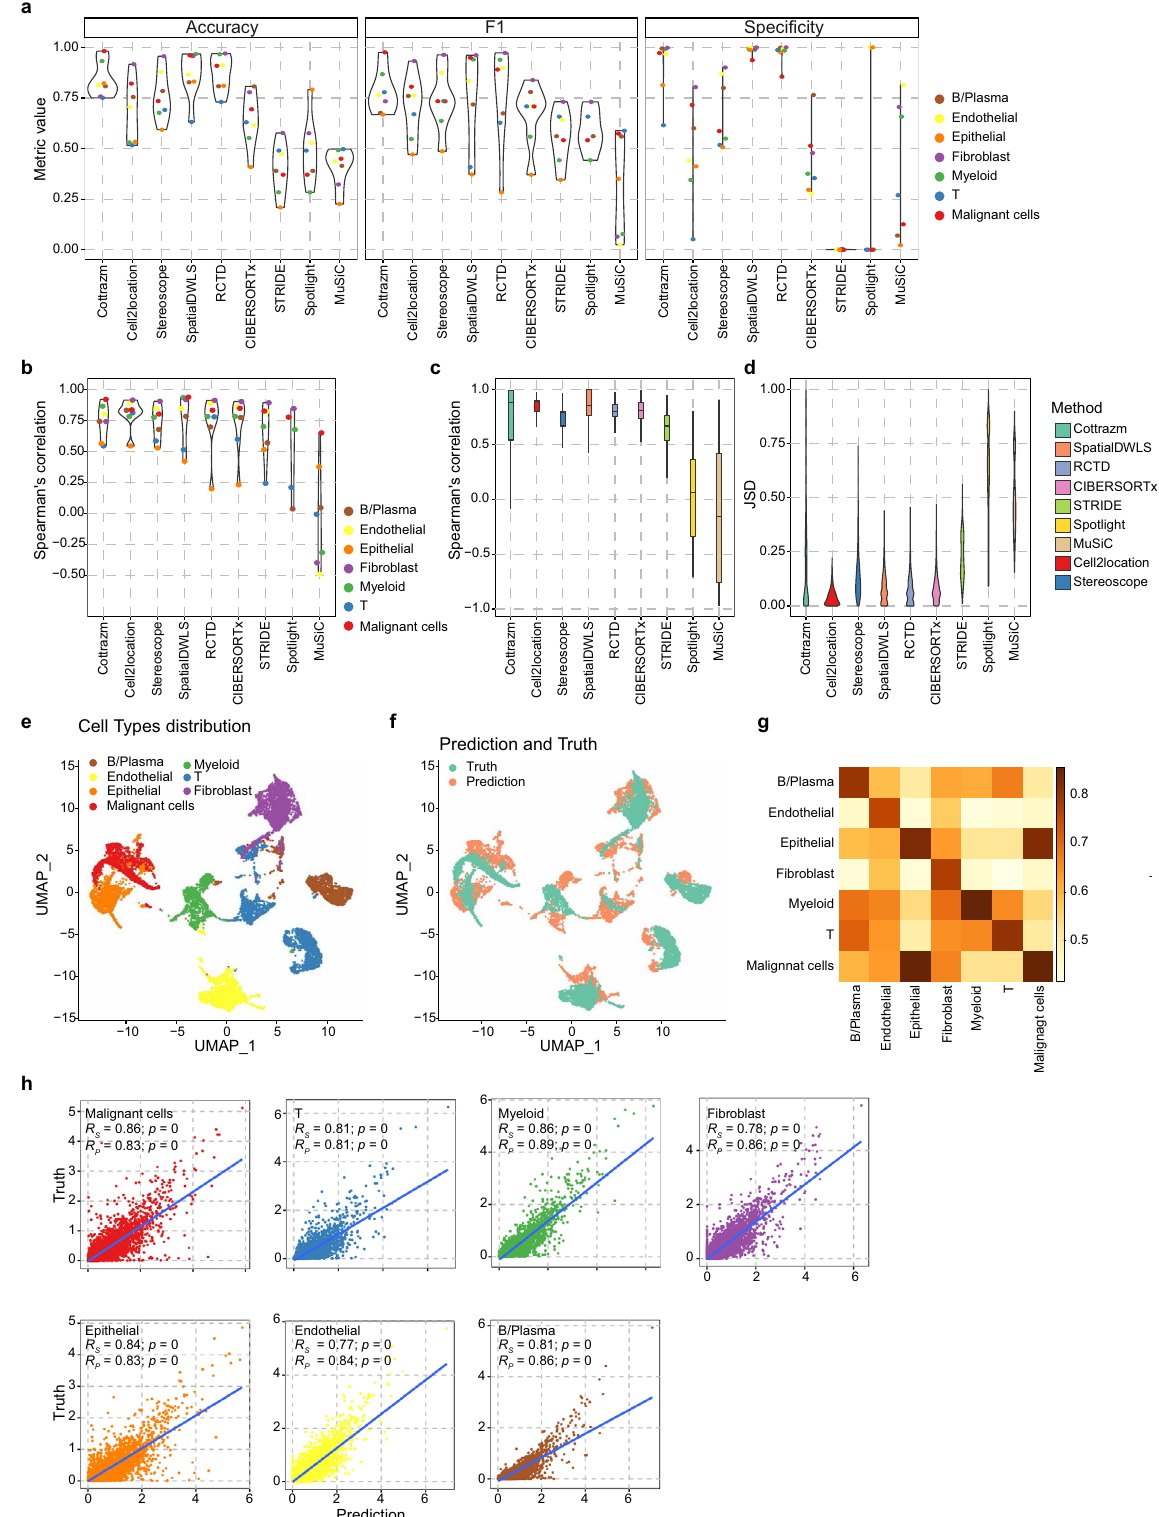
malignant cells, but were absent of T cells or other cell in fi ltration. The boundary spots consisted of myeloid cells, fi broblast cells, and endo- thelial cells, whereas non-malignant spots excluded malignant cells and hadvarious cellularcomposition characteristicsdepending on the tissue location (Fig. 4a, b). Tertiary lymphoid structures (TLSs) are ectopic lymphoid organs that develop in non-lymphoid tissues at sites